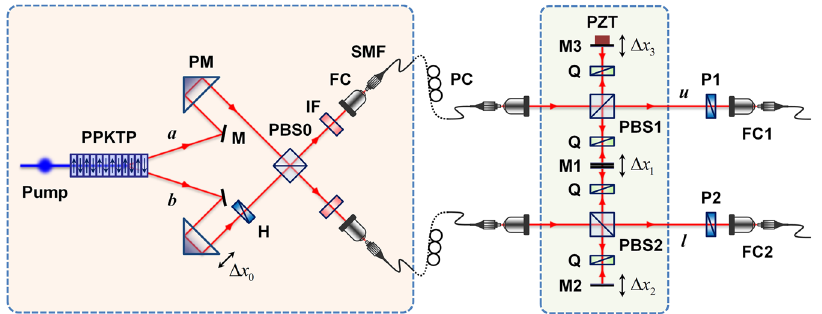
Figure 1. Experimental setup to observe two-photon interference effect. Pump, continuous-wave (cw) single-mode diode laser (406.2 nm, 5 mW); PM, prism mirror; M, mirror; H, half-wave plate; PBS, polarizing beamsplitter; IF, interference filter; FC, fibre coupler; SMF, single-mode fibre; PC, polarization controller; Q, quarter-wave plate; PZT, piezoelectric transducer; P1 and P2, linear polarizers. In particular, we use a double-sided mirror (M1) for simultaneous adjustment of the path-length differences between the two long interferometer arms in the opposite direction, while the relative phase differences between them always remain at